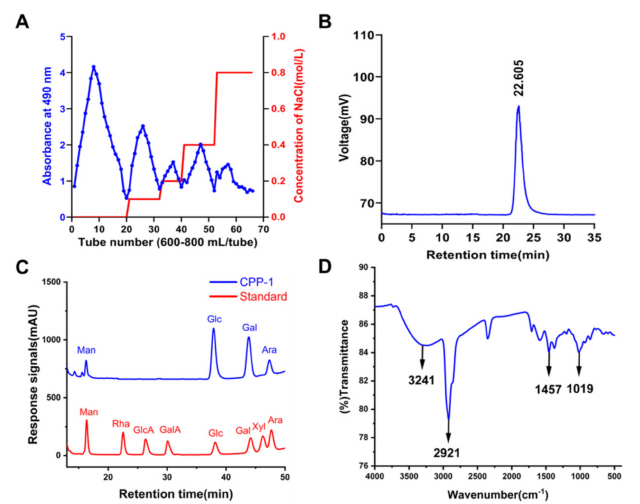
Figure 1. ( A ) The eluted profile of CPP80 on the DEAE-52 column; ( B ) HPGPC-ELSD result of CPP − 1; ( C ) the results of monosaccharide composition analysis of CPP − 1; ( D ) FT-IR spectrum of CPP − 1 in the range of 4000–400 cm − 1